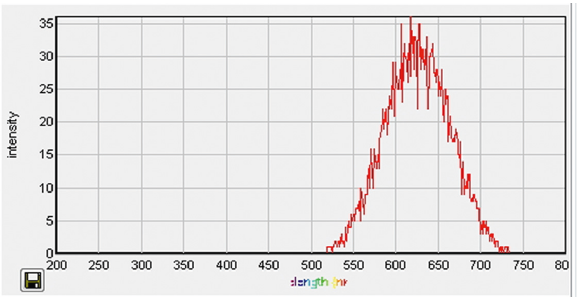
Figure 7: Screenshot of the light intensity measured using the proposed simulation technique.